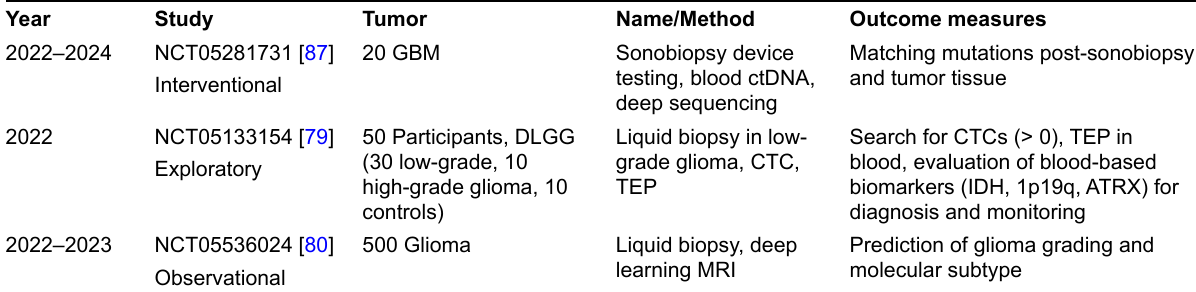
Table 3. Current clinical studies using liquid biopsy in glioblastomas ( continued ) Year